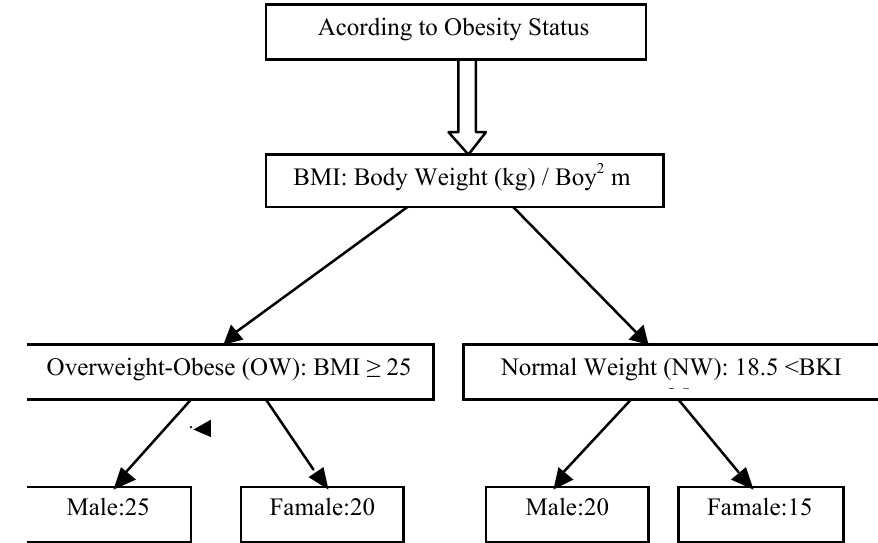
Figure 1. Participation in the study acording to obesity status